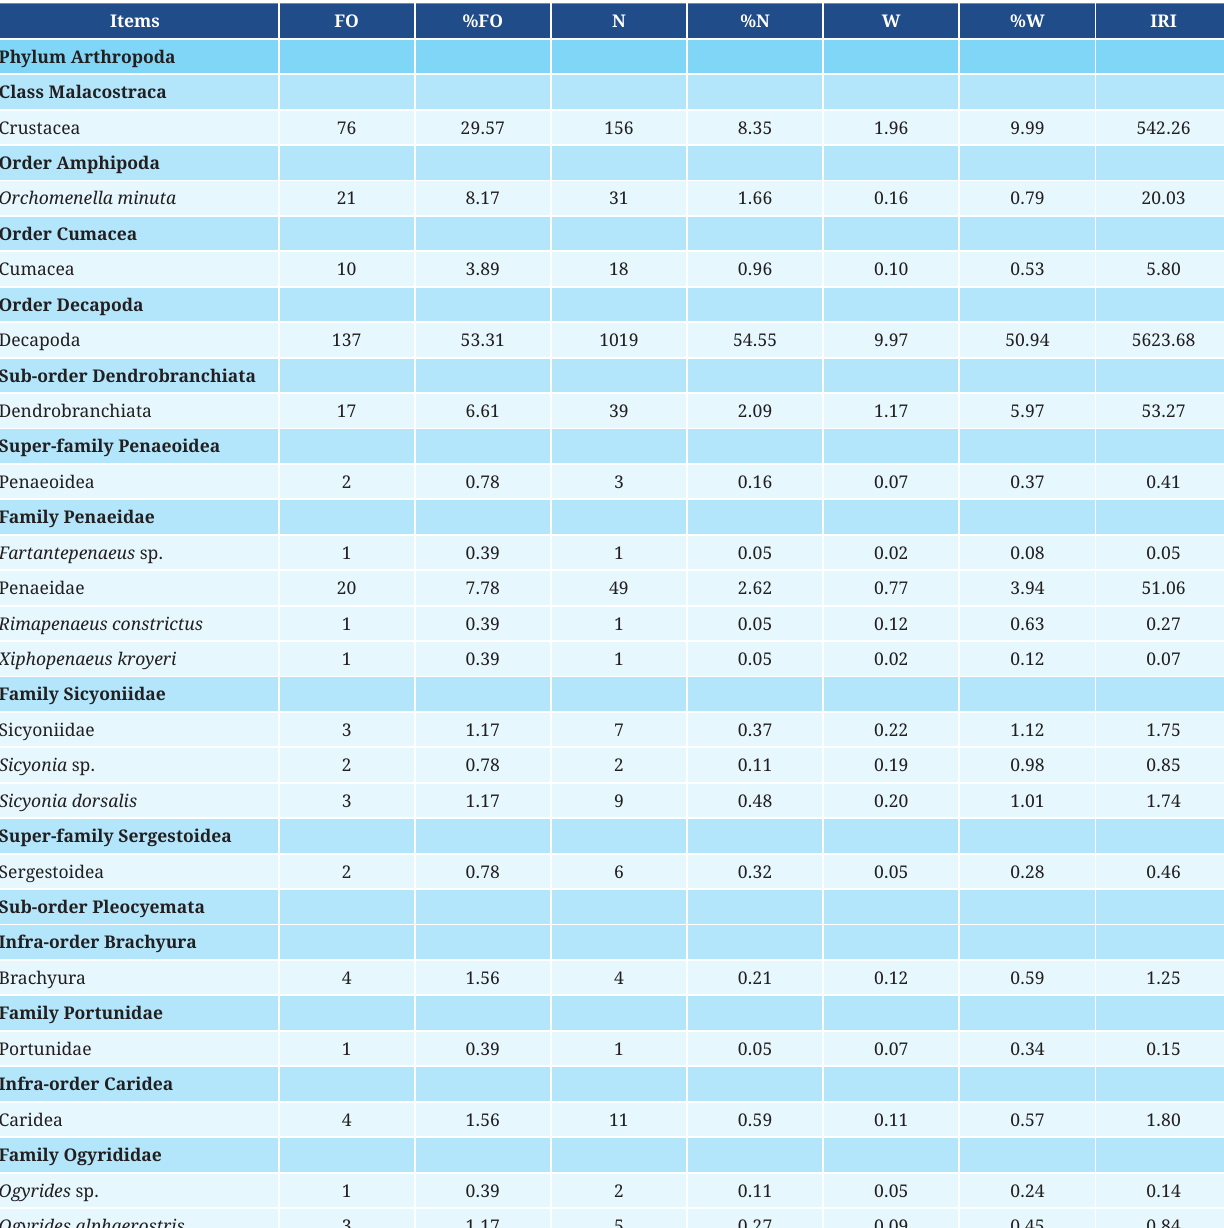
TABLE 1 | Frequency of occurrence (FO), Percentage frequency of occurrence (%FO), Number (N), Percentage by number (%N), Weight (W), Percentage by weight (%W), and Index of importance (IRI) of food items present in the diet of Urotrygon microphthalmum